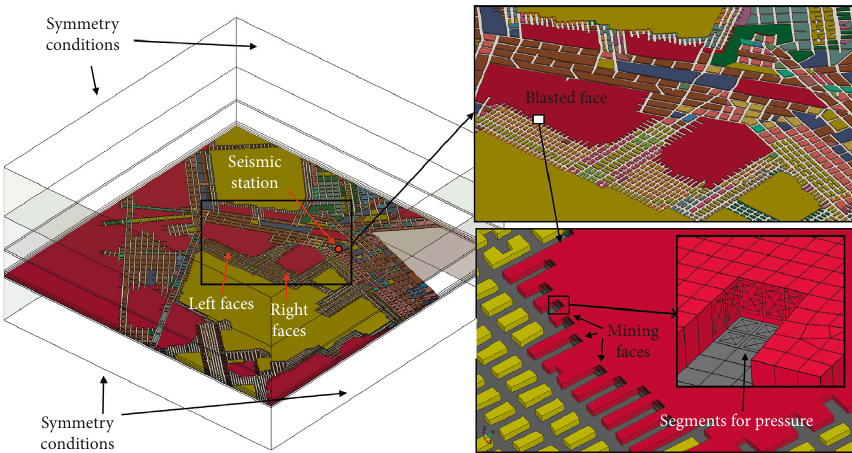
Figure 5: Model of blast in global scale with initial-boundary conditions.